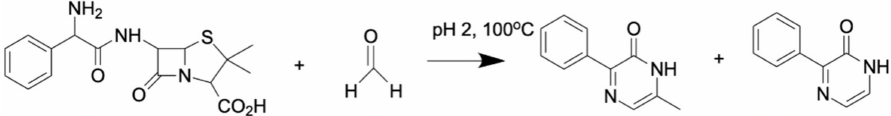
Figure 4. FA reaction with ampicillin results in formation of fluorescent pyrazine-2-one.